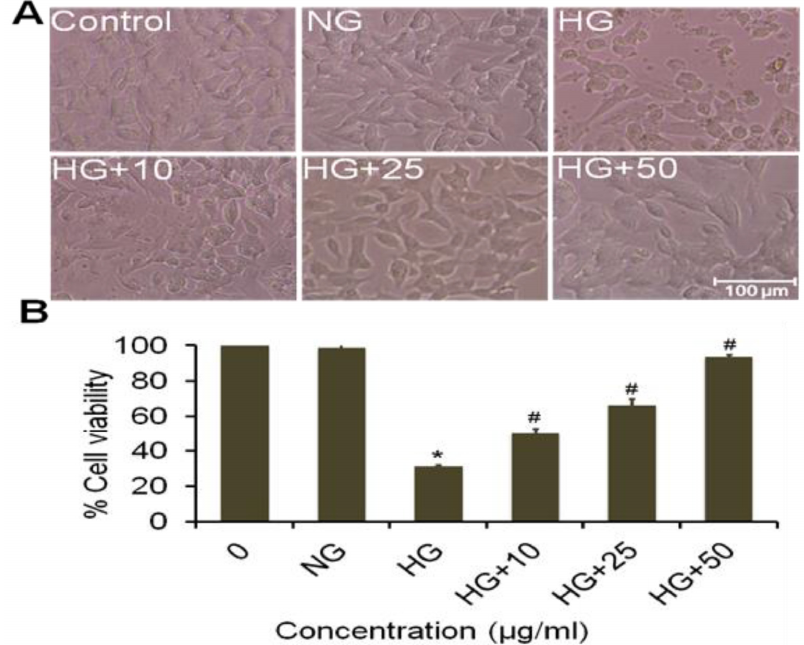
Figure 2. In vitro neuroprotective effects of A. napellus extract against mammalian neuroblastoma SHSY5Y cells ( A ) Photomicrograph of SHSY5Y cell line treated with NG, HG and 10 to 50 µ g / mL concentration of ACON extract ( B ) Dose-response e ff ects of NG, HG and A. napellus extract at di ff erent concentrations on SHSY5Y cell line for 24 h. All values were expressed as Mean ± SEM. * p < 0.05, high glucose vs normal glucose group; # p < 0.05, as compared to high